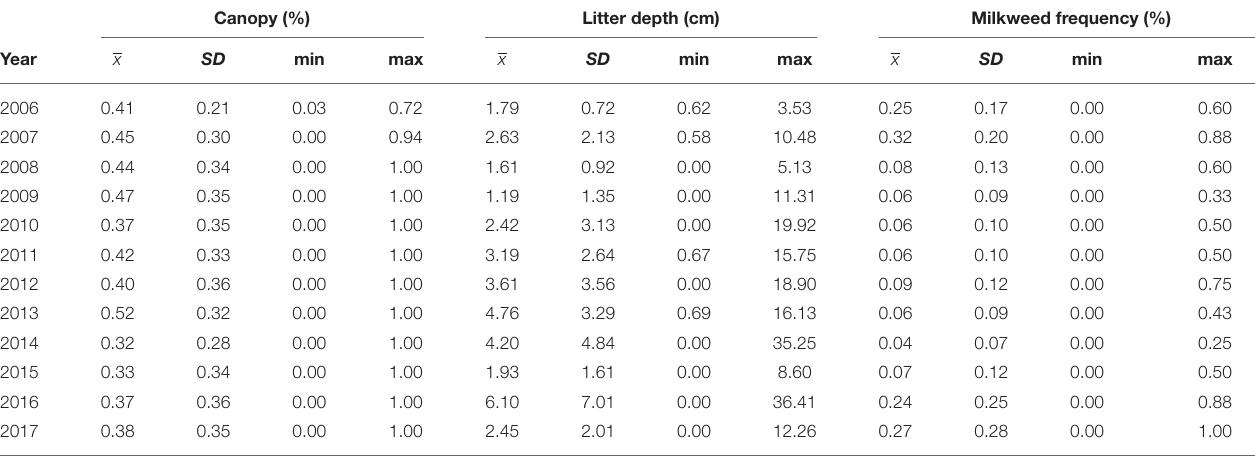
TABLE 4 | Yearly estimates (mean, SD, and range) of the average measures of three site-specific covariates (canopy cover [%], litter depth [cm], and milkweed frequency [%]) at all sites surveyed in that year, Iowa, 2006–2017. Canopy (%) Litter depth (cm) Milkweed frequency (%)